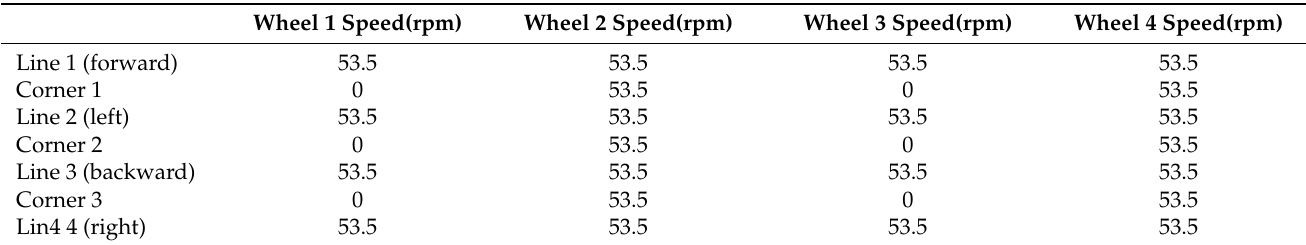
Table 11. Inputs for the differential drive with loop kinematic solution—values.